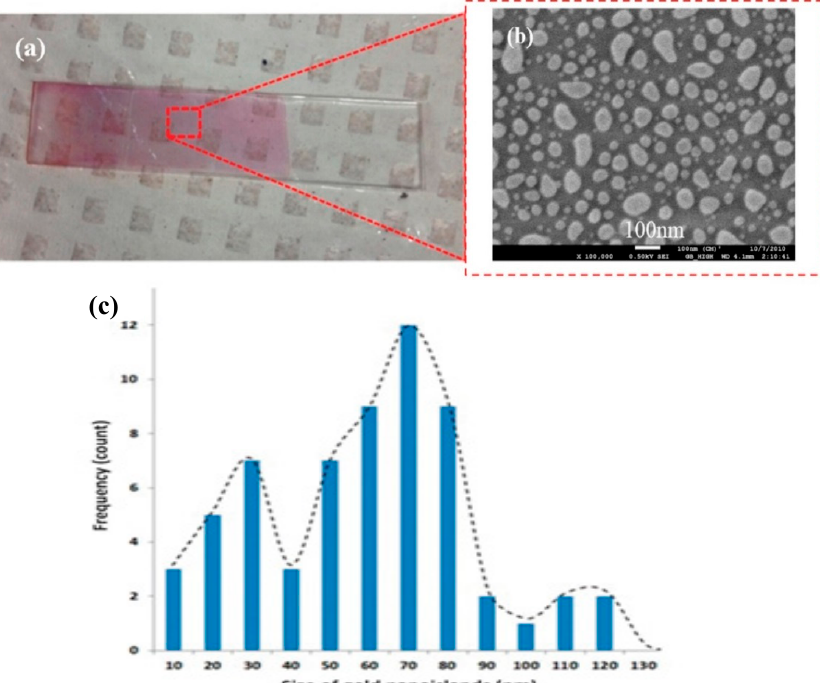
Figure 8. ( a ) Glass substrate with gold nano-islands, ( b ) scanning electron micrograph of gold nano-islands, and ( c ) size distribution of nano-islands (reproduced with permission from [44], copyright 2015, American Dairy Science Association).